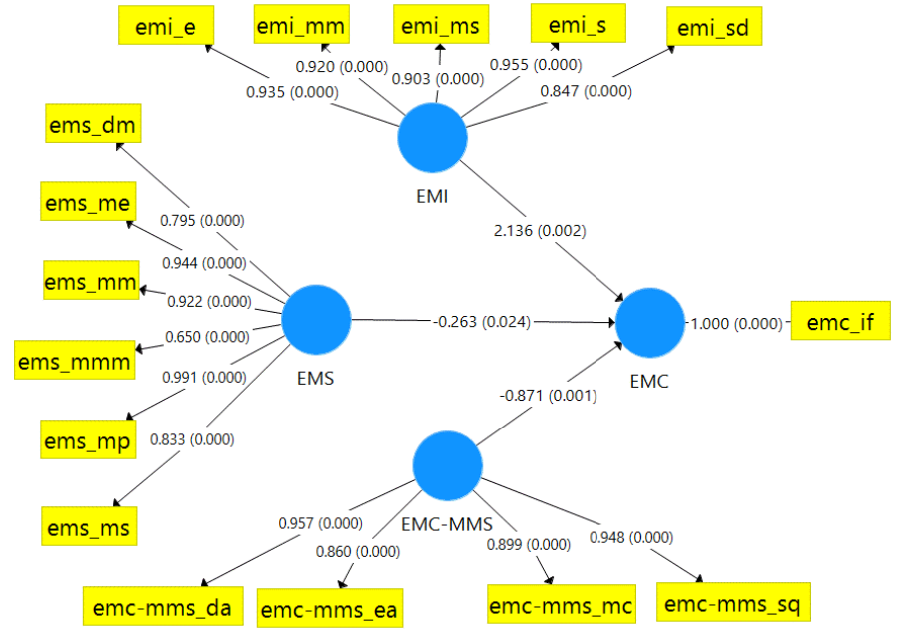
Figure 3. Model results (Source: results from Smart-PLS software 3.3.3).